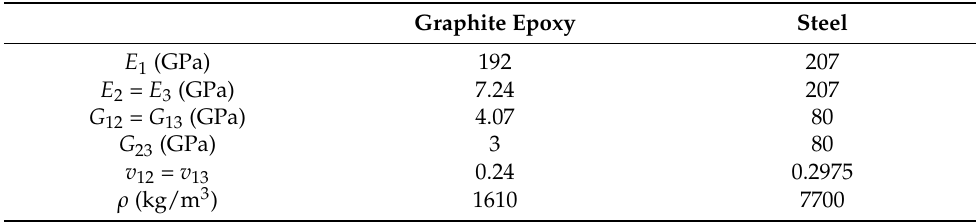
Table 1. Performance parameters of epoxy-resin-based graphite fibers.